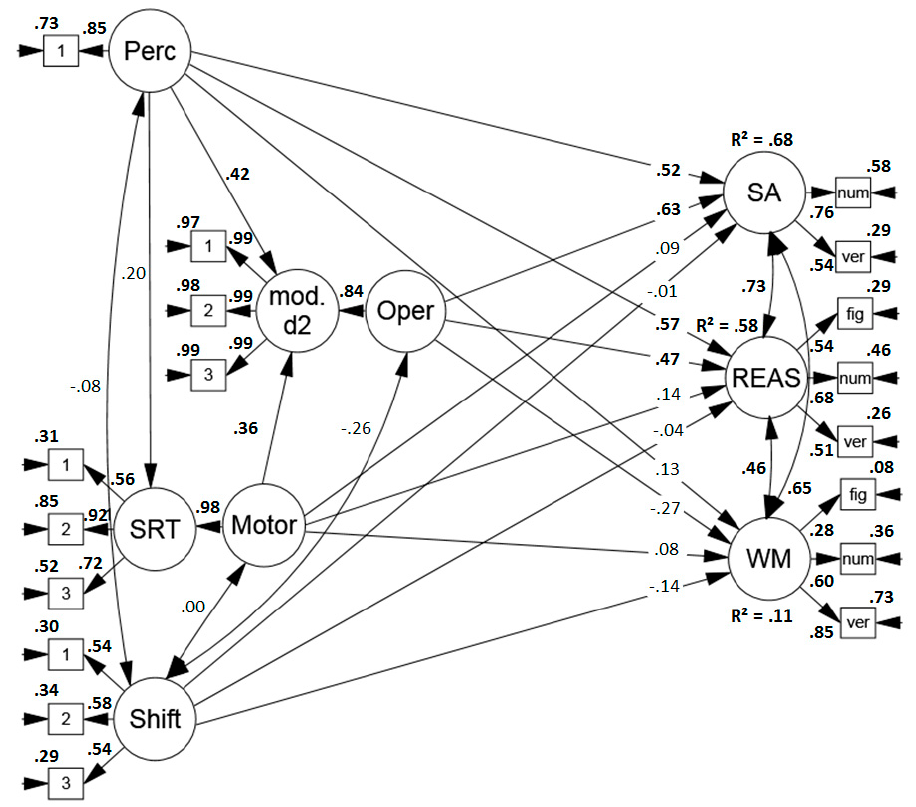
Figure 4. Standardized solution of the model predicting performance in sustained attention tests (convergent validity, without the d2-R as dependent variable), reasoning and working memory span tasks (discriminant validity) based on the proposed process model of sustained attention tests. Significant results are printed in boldface. Perc = perceptual speed, mod. d2 = modified d2, Oper = operation speed, SRT = simple reaction time task, Motor = motor speed, Shift = item shifting speed, SA = sustained attention, REAS = reasoning, WM = working memory span, fig = figural task, num = numerical task, verb = verbal task.